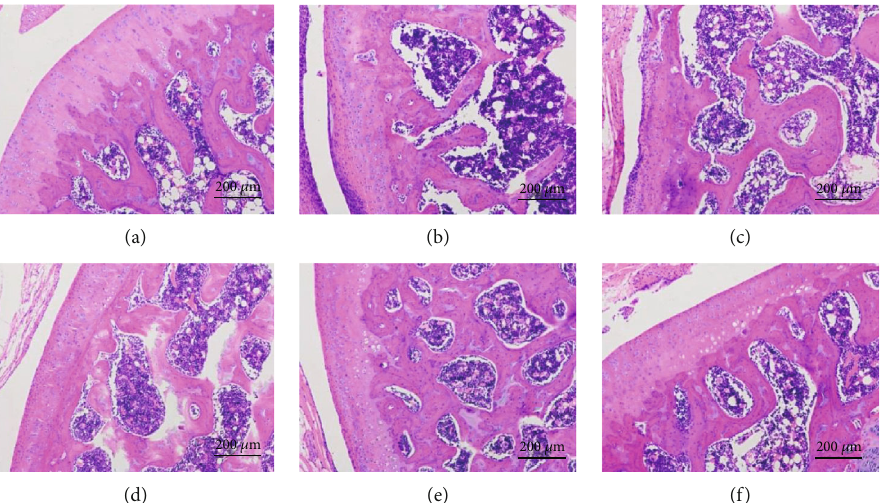
Figure 4: HE staining was used to evaluate the therapeutic e ff ects of matrine and MTX on CIA rats. HE staining (magni fi cation: 100x): (a) healthy group; (b) CIA control group; (c) low dosage matrine group (25 mg/kg matrine group); (d) medium dosage matrine group (50 mg/kg matrine group); (e) high dosage matrine group (100mg/kg matrine group); (f) methotrexate group (2 mg/kg MTX group).